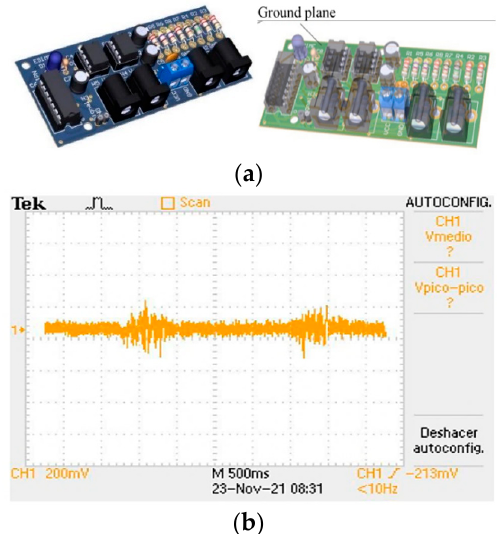
Figure 6. ( a ) EMG signal acquisition cards, ( b ) EMG signal response in the Tektronix oscilloscope.